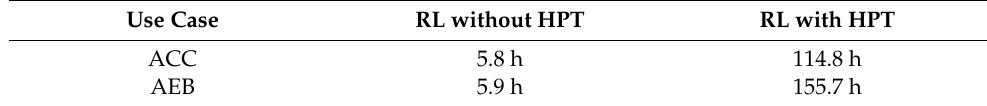
Table 5. Execution time of the experiment.